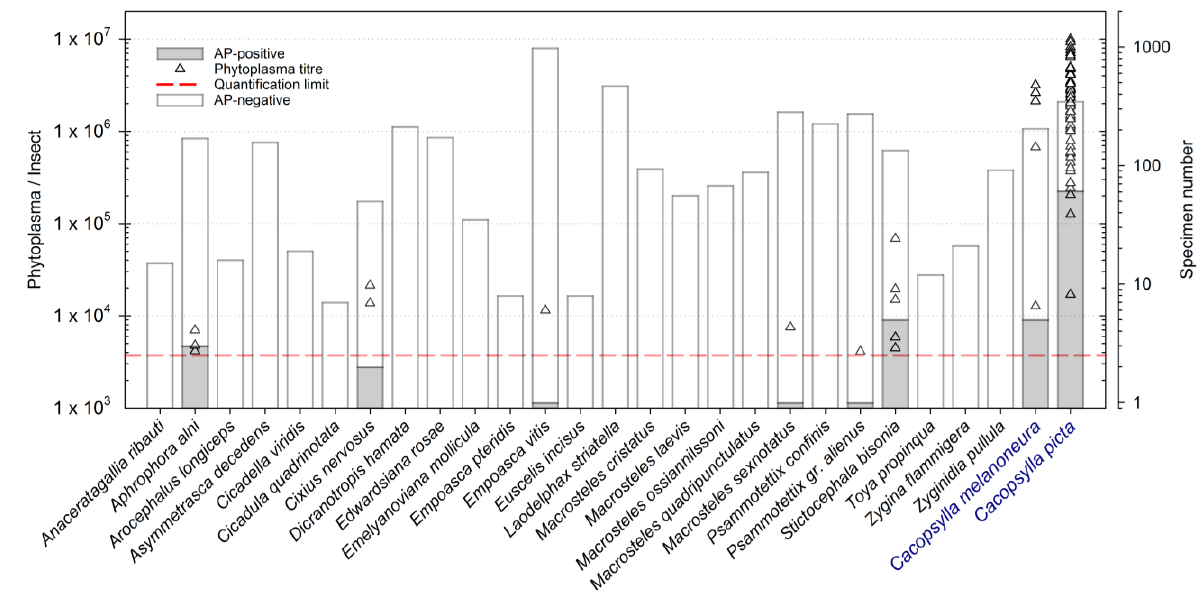
Figure 2. Results of the phytoplasma quantification in selected Auchenorrhyncha species. Quantification was performed by qPCR. The number of tested individuals per species ( x -axis) is indicated by the bar plot (right y -axis). The grey colored part of the bars indicates the number of AP-positive individuals. The triangles are referring to the left y -axis and provide information about the phytoplasma concentration in the AP-positive individuals of the respective species. The red dashed line indicates the phytoplasma detection limit.